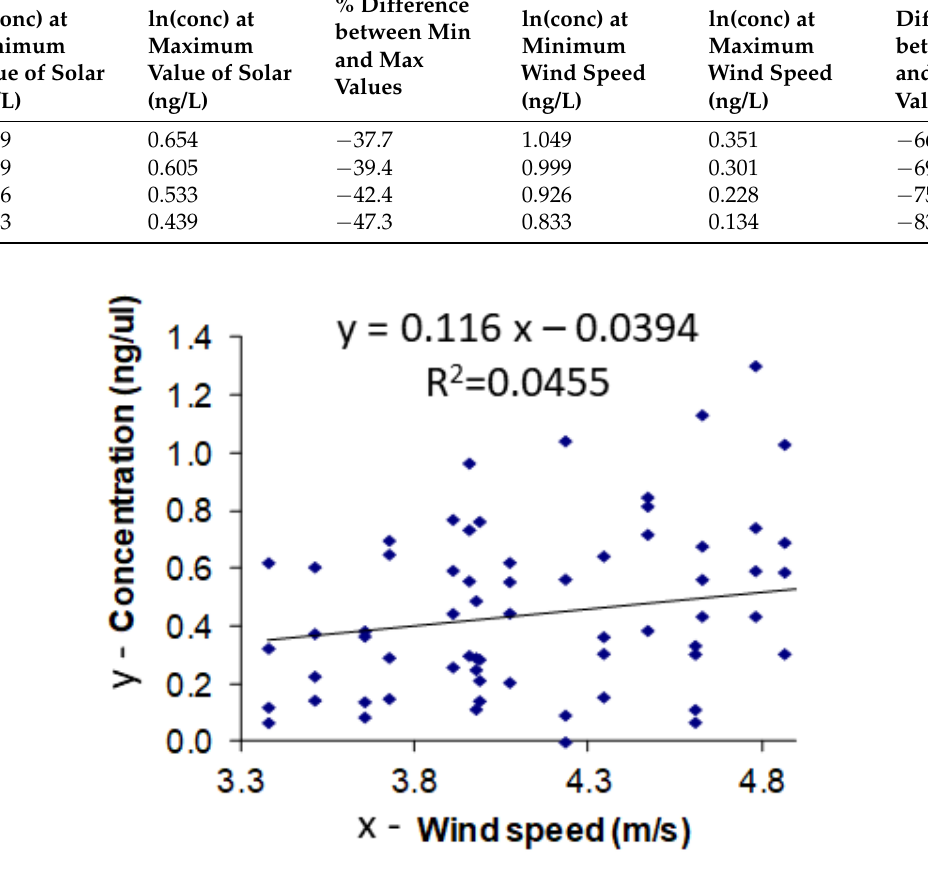
Figure 2. Sampled concentration of RbCl as a function of wind speed. Table 2. Modeled ln (concentration) at minimum and maximum values of variables wind speed and solar radiation for Weather Method 1. Value of the other variable was held to minimum value to illustrate the effect of changes in the variable of interest.